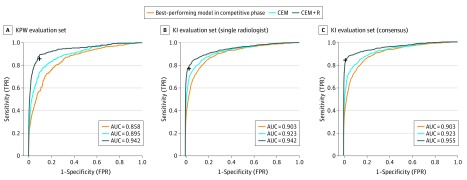
Receiver Operating Characteristic Curves of the Best Individual CEM and CEM+R MethodsReceiver operating characteristic curves of the best individual method (orange), challenge ensemble method (CEM) (light blue), and challenge ensemble method + radiologist (CEM+R) method (dark blue) in Kaiser Permamente Washington (KPW) (A) and Karolinska Institute (KI) (B-C) data sets for single radiologist and consensus. The black cross reports the sensitivity and specificity achieved by the radiologist(s) in the corresponding cohort. AUC indicates area under the curve; FPR, false-positive rate; TPR, true-positive rate.